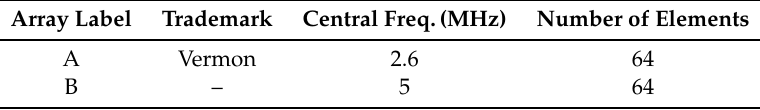
Table 2. List of arrays employed in the following experiences. Array